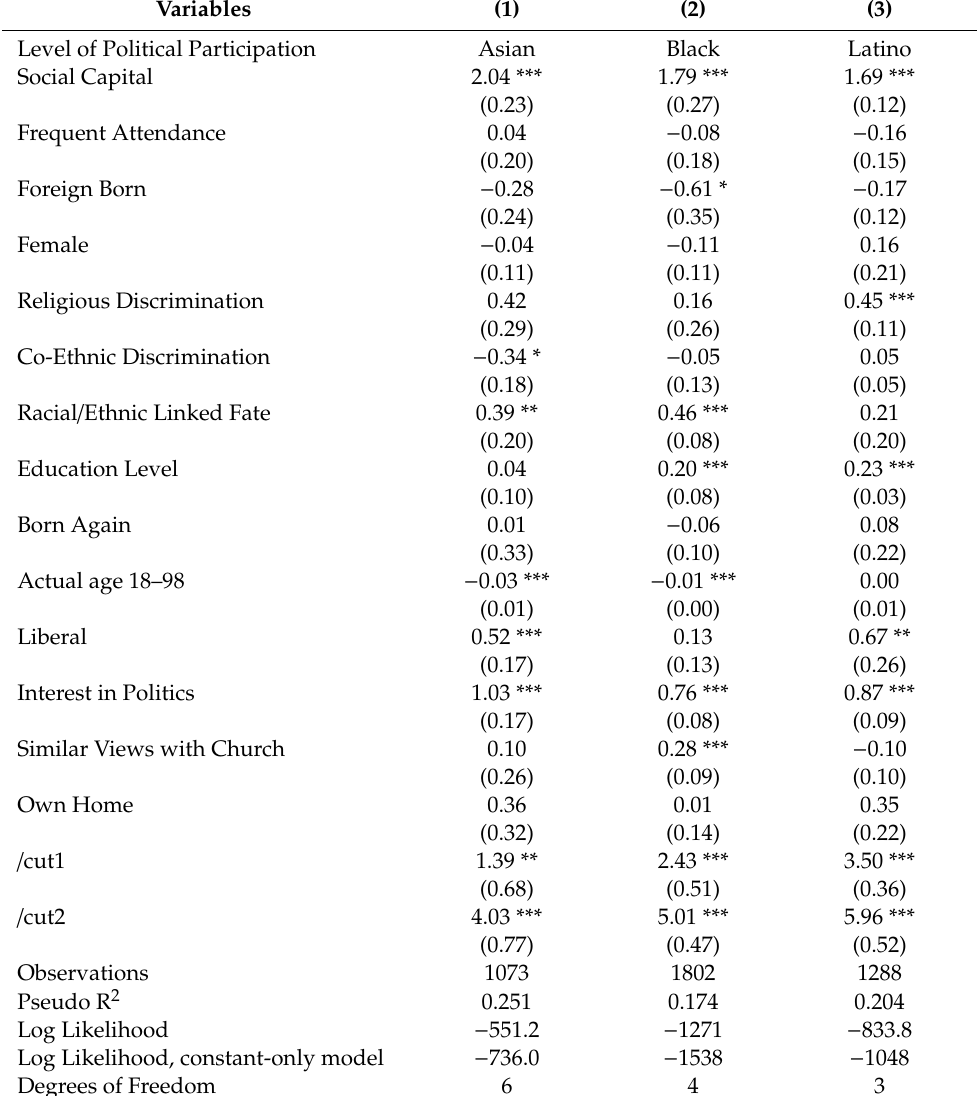
Table 4. Odds ratio of the e ff ect of social capital and frequent attendance on political participation (robust standard errors clustered around